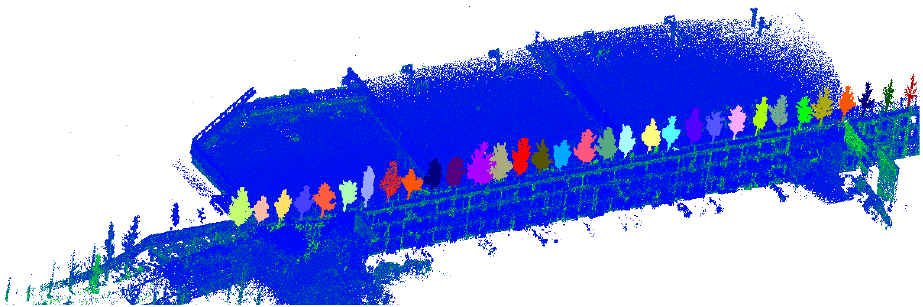
Figure 13. The segmentation results in one scene.